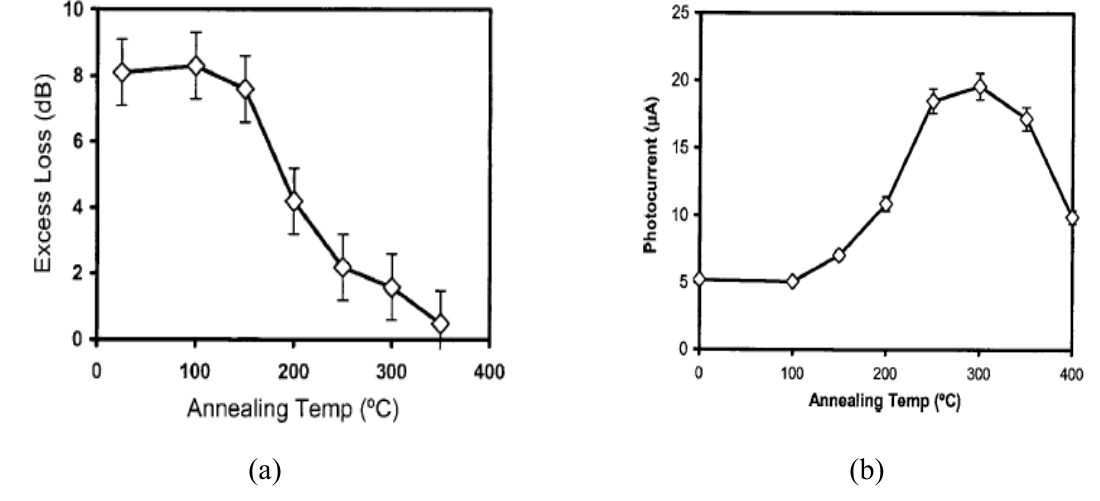
Figure 7. Optical loss (a) and photocurrent (b) vs. post-implantation annealing temperature for an ion-implanted integrated photodiode [48]. Reprinted with permission from A.P. Knights, et al. Copyright © 2006